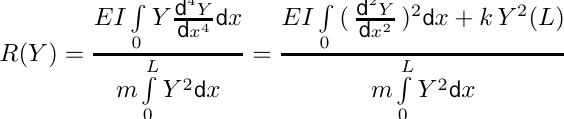
Fig. 4. RRMM second eigenfunction convergence (3, 4, ... , 8